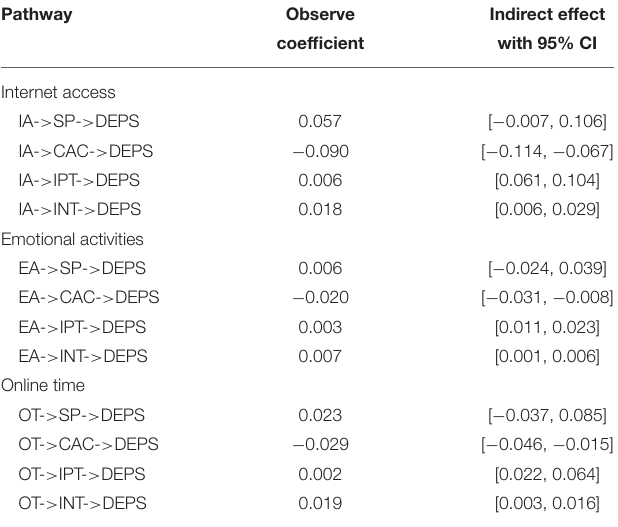
TABLE 3 | Mediation and suppression effects.